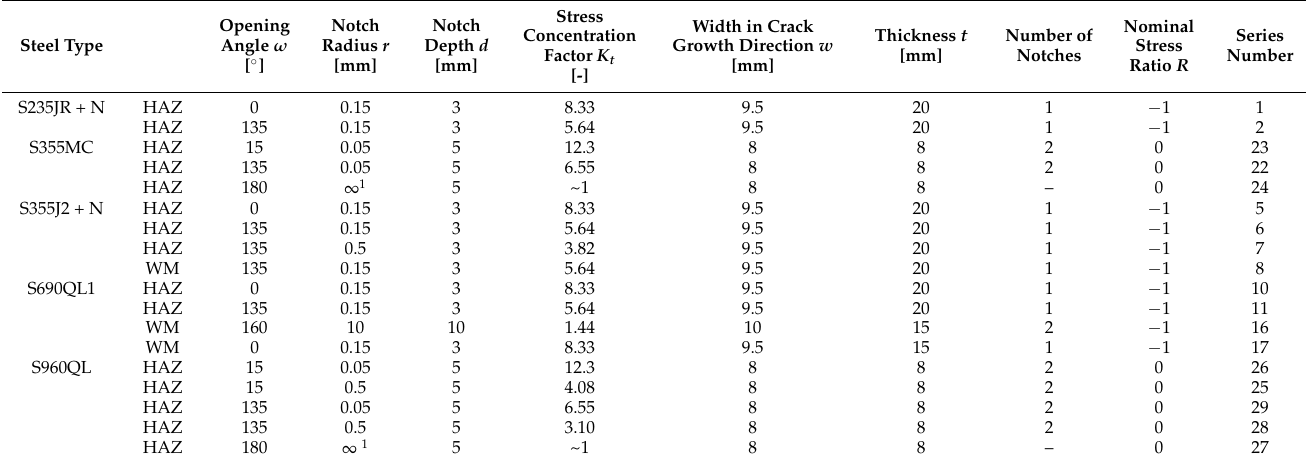
Table 1. Overview of artificially notched welded specimens.